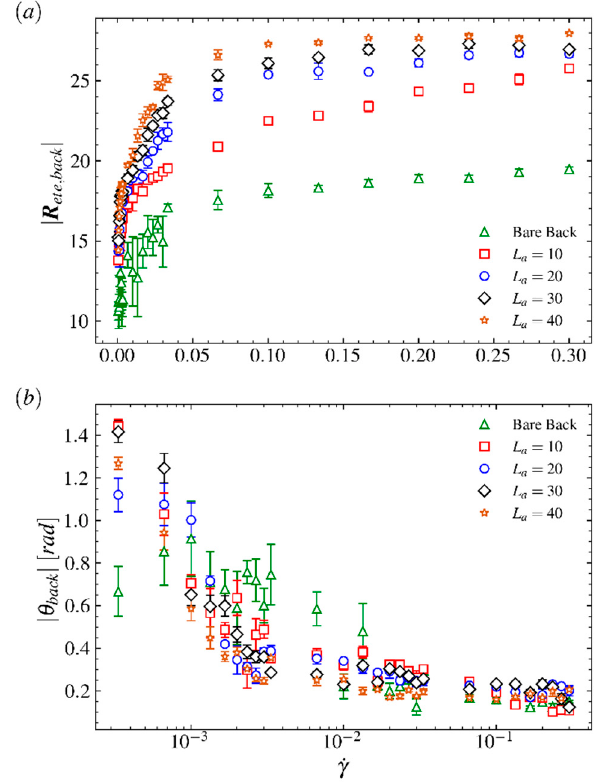
Figure 6. ( a ) The end-to-end distances of the fully stretched backbone for the bare backbone and the LCB polymer as a function of Weissenberg number Wi . ( b ) The angles that the backbone’s end-to-end vectors make with respect to flow direction at flow gradient plane (i.e., xoz plane) as a function of Weissenberg number Wi ; here the unit of angle is radian.